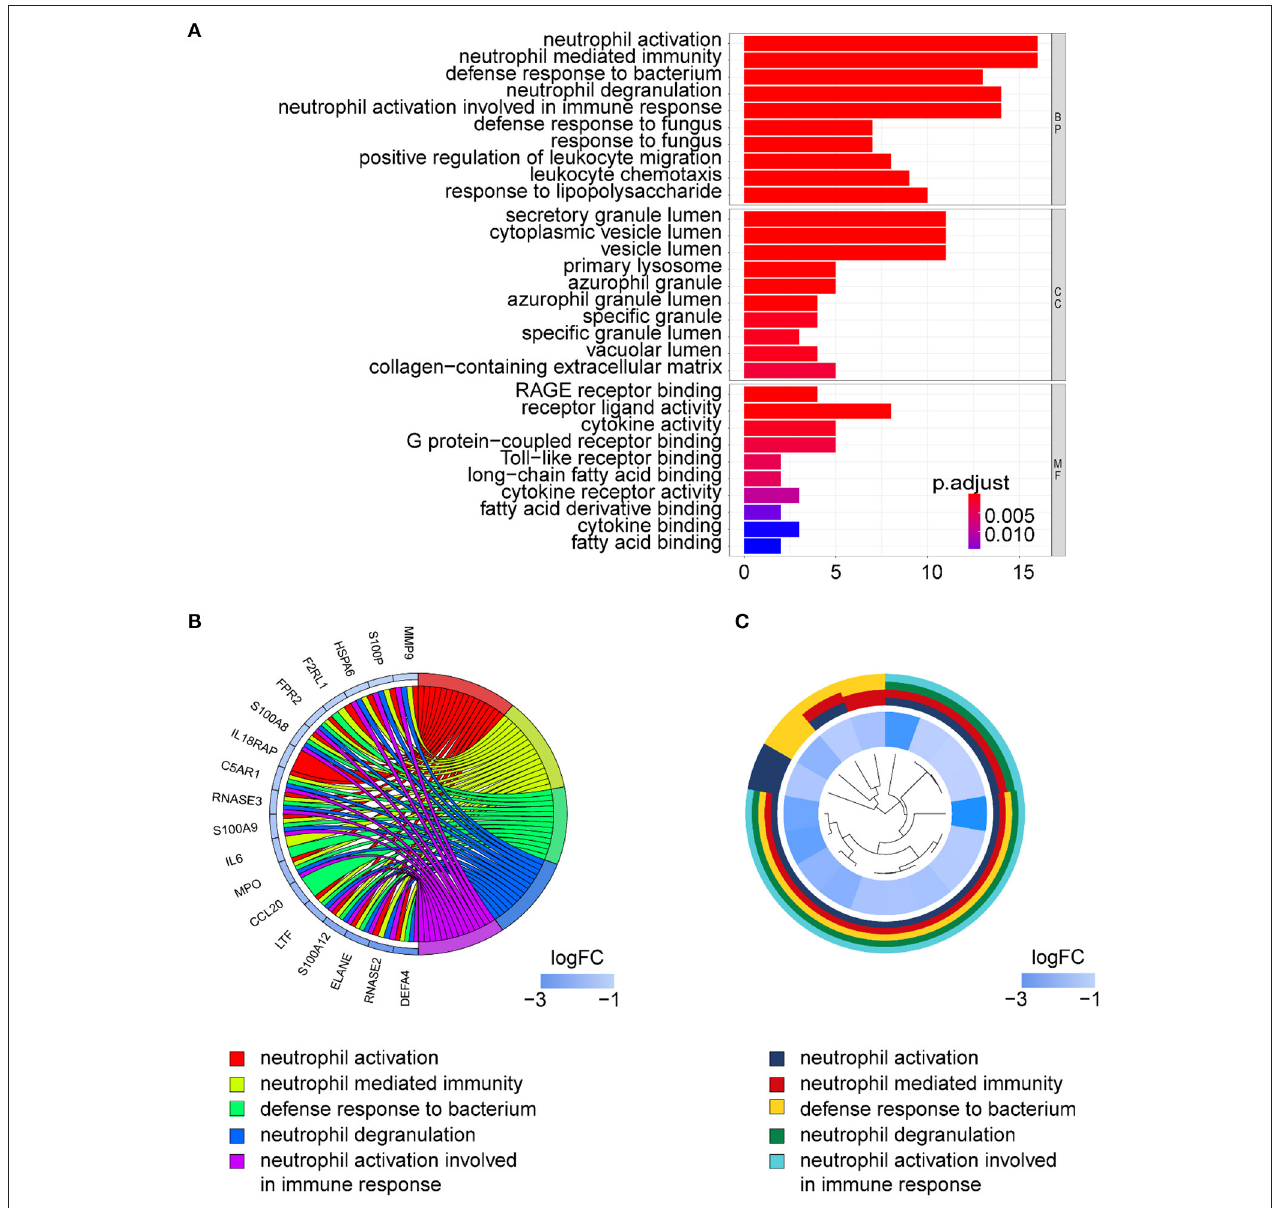
FIGURE 6 | GO analysis of DE-IGs between liver with inflammation and fibrosis livers in BA. (A) The 10 most significantly enriched GO terms are displayed in the barplot. The length of the bar represents the number of genes enriched, and the color represents the correlation. BP, biological process; CC, cellular component; MF, molecular function. (B) GO chord diagram of the DE-IGs. The outer circle represents different genes and GO terms. The color depth of the outer circle of genes represents the logFC indicating the gene expression level. The internal colorful ribbon represents the different GO terms the genes enriched. (C) The GO cluster of the DE-IGs. The outer circle represents the GO terms that the genes enriched, and the inner circle represents the logFC of each gene, with the color depth corresponding to the gene expression level.